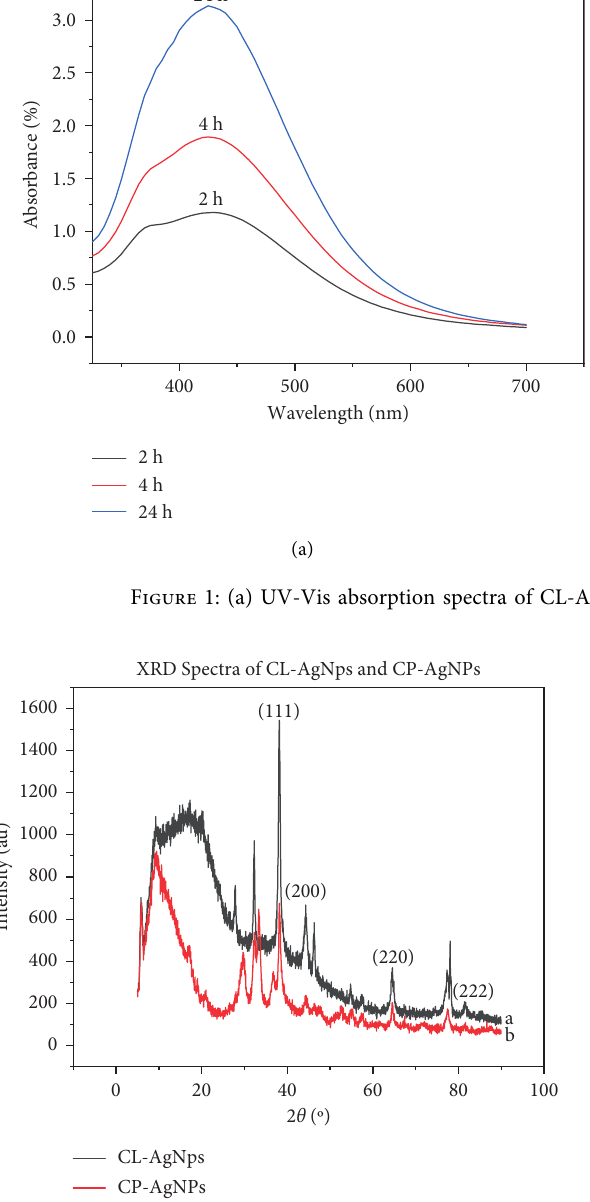
Figure 2: (a) XRD spectra of CL-AgNPs. (b) XRD spectra of CP-